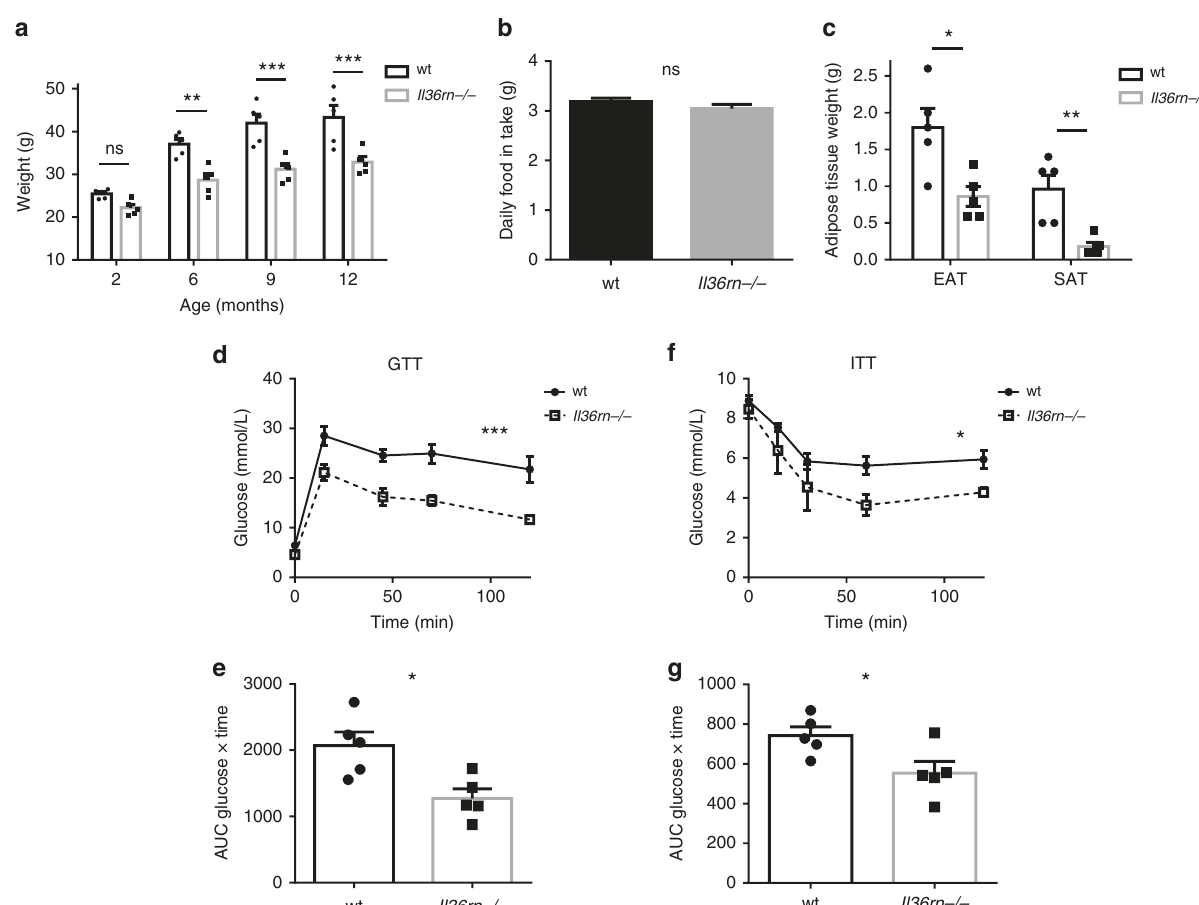
Fig. 2 Il36rn − / − mice are protected from spontaneous weight gain and metabolic dysfunction. a – e Male Il36rn − / − and wt control mice of the same age were kept on normal chow diet up to 12 months of age ( n = 5 per group). Weights ( a ) and daily food intake per mouse ( b ) were monitored over time from 2 months of age. c EAT and SAT depots mass was measured at 12 months of age. d , e Intraperitoneal glucose tolerance test (GTT) performed at 9 months of age; glucose measurements over time after glucose bolus-injected i.p. ( d ) and area under curve (AUC) ( e ) shown. f , g Intraperitoneal insulin tolerance test (ITT) performed at 9 months of age; glucose measurements over time after insulin bolus-injected i.p. ( f ) and AUC ( g ) shown. Data represent means ± SEM. Statistical analysis using two-tailed unpaired student ’ s t -test, or RM two-way ANOVA with Bonferroni ’ s correction for multiple comparisons for ( a ), ( d ) and ( f ). ns p > 0.05, * p < 0.05, ** p < 0.01, *** p < 0.001. Source data are provided as a Source Data fi